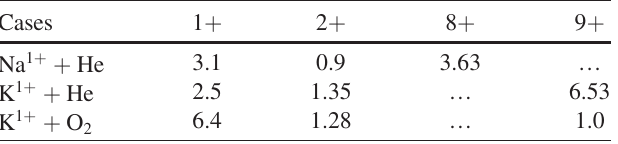
TABLE I. Charge breeding efficiency results (percentages) obtained from the three experimental cases. The relative un- certainty is about 5% for the low charge states ( 1 þ and 2 þ ) and 10% for the high charge states ( 8 þ and 9 þ ).